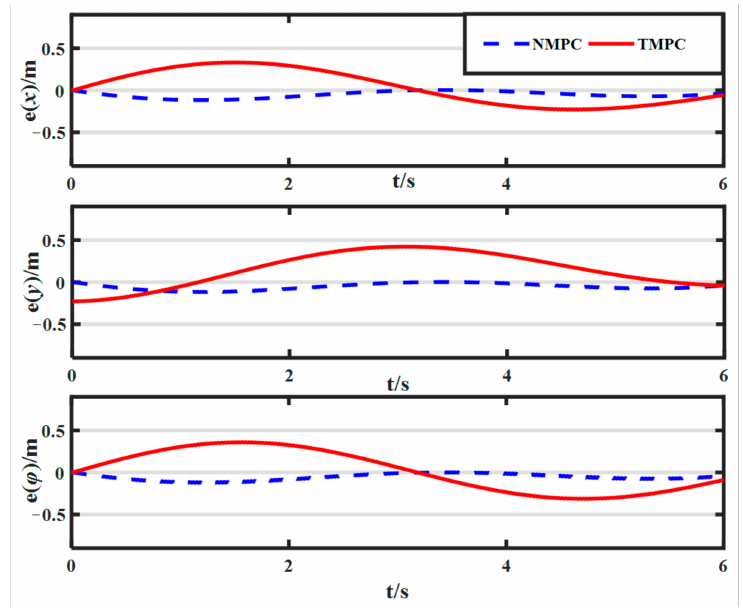
Figure 7. The tracking errors of x , y , and ϕ under the SCT.